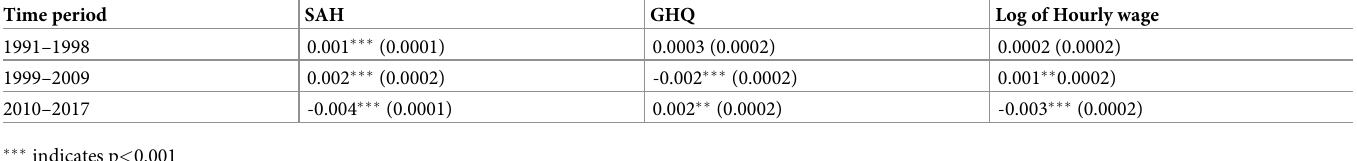
Table 2. Trends in the intergenerational correlation in SAH, GHQ, and log of hourly wage for the entire sample over the period 1991–2017. Time period Log of Hourly